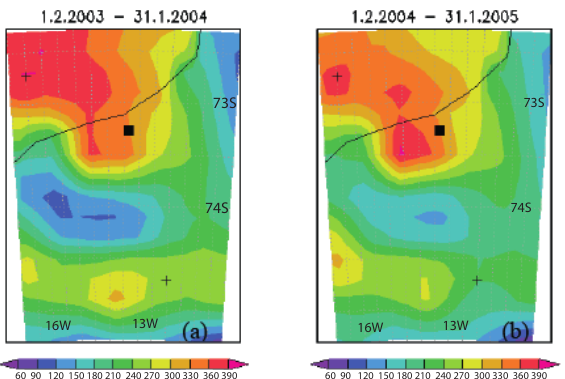
Fig. 12. Cumulative precipitation (in mm water equivalent) in the measurement area (72–75 ◦ S, 343–350 ◦ E) according to ECMWF operational 24-h forecasts for (a) an annual period ending on 31 Jan- uary 2004 (end of the measurement campaign) and (b) an annual period ending on 31 January 2005 (end of the measurement cam- paign). The upper cross, the square, and the lower cross mark the location of Rampen, Aboa, and Svea, respectively.